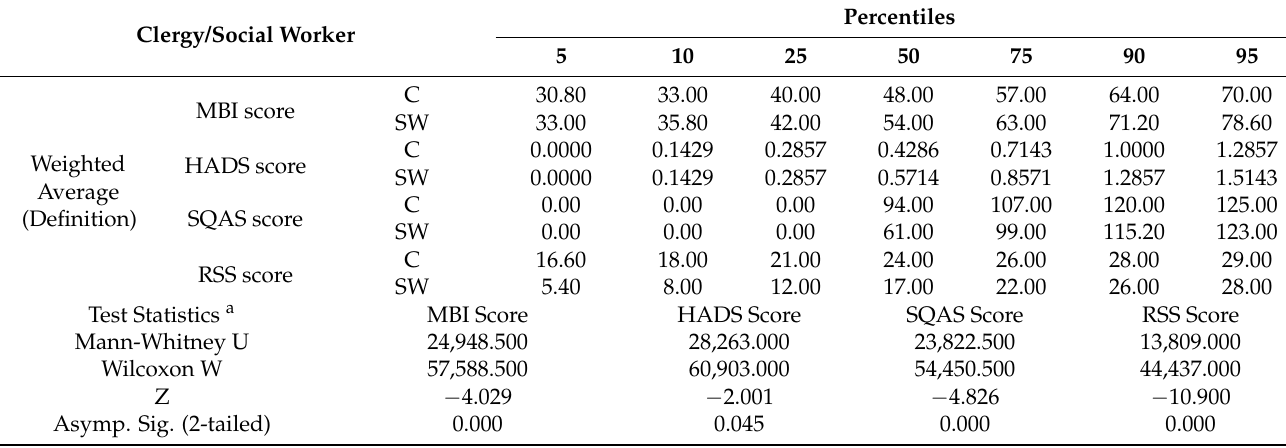
Table 2. Comparative analysis of the median and percentiles 25–75 between the scores obtained in the four scales by the two subgroups (social workers and